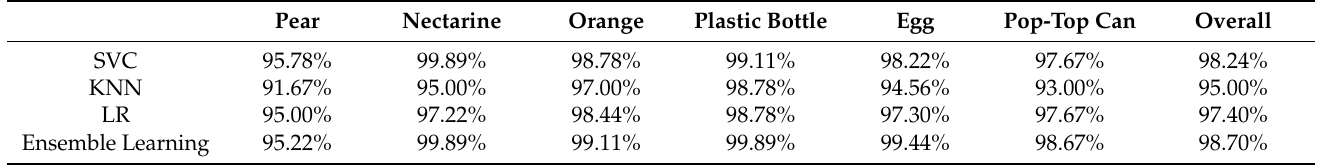
Table 1. Comparison of the judgment accuracy of different algorithms at a training ratio of 0.6.